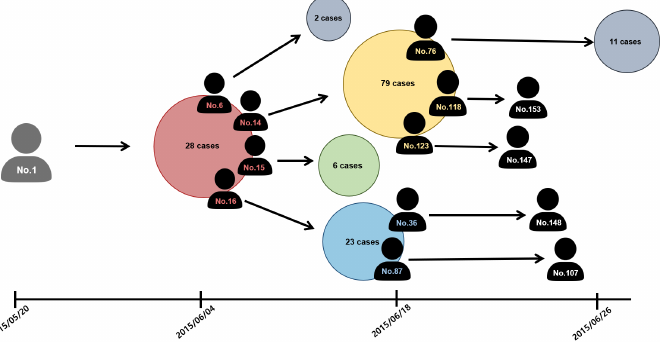
Figure 1. Middle East Respiratory Syndrome Coronavirus (MERS-CoV) transmission trees and super-spreaders are displayed. This showed a high level of heterogeneity in generating secondary cases.